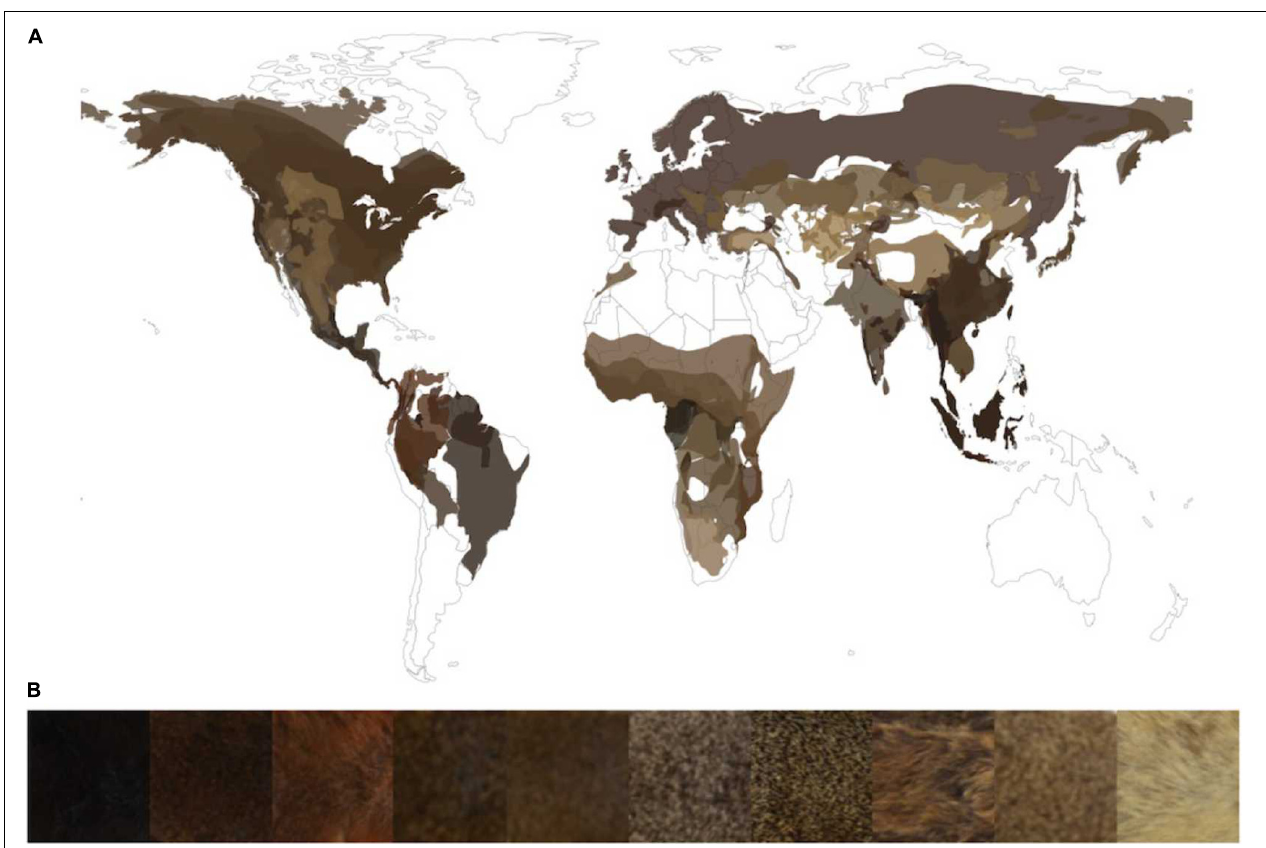
FIGURE 1 | (A) Average dorsal color of all species for which we have photo and distribution data superimposed onto that species range map. (B) Dorsal regions of select squirrel species showing the distribution of pelage luminance across the Sciurid family. The representative species from left to right are as follows: Callosciurus finlaysonii, Sciurus aestuans, Sciurus vulgaris, Sundasciurus samarensis, Callosciurus nigrovittatus, Sciurus yucatanensis, Notocitellus adocetus, Petaurillus kinlochii, Urocitellus townsendii, Callosciurus finlaysonii.